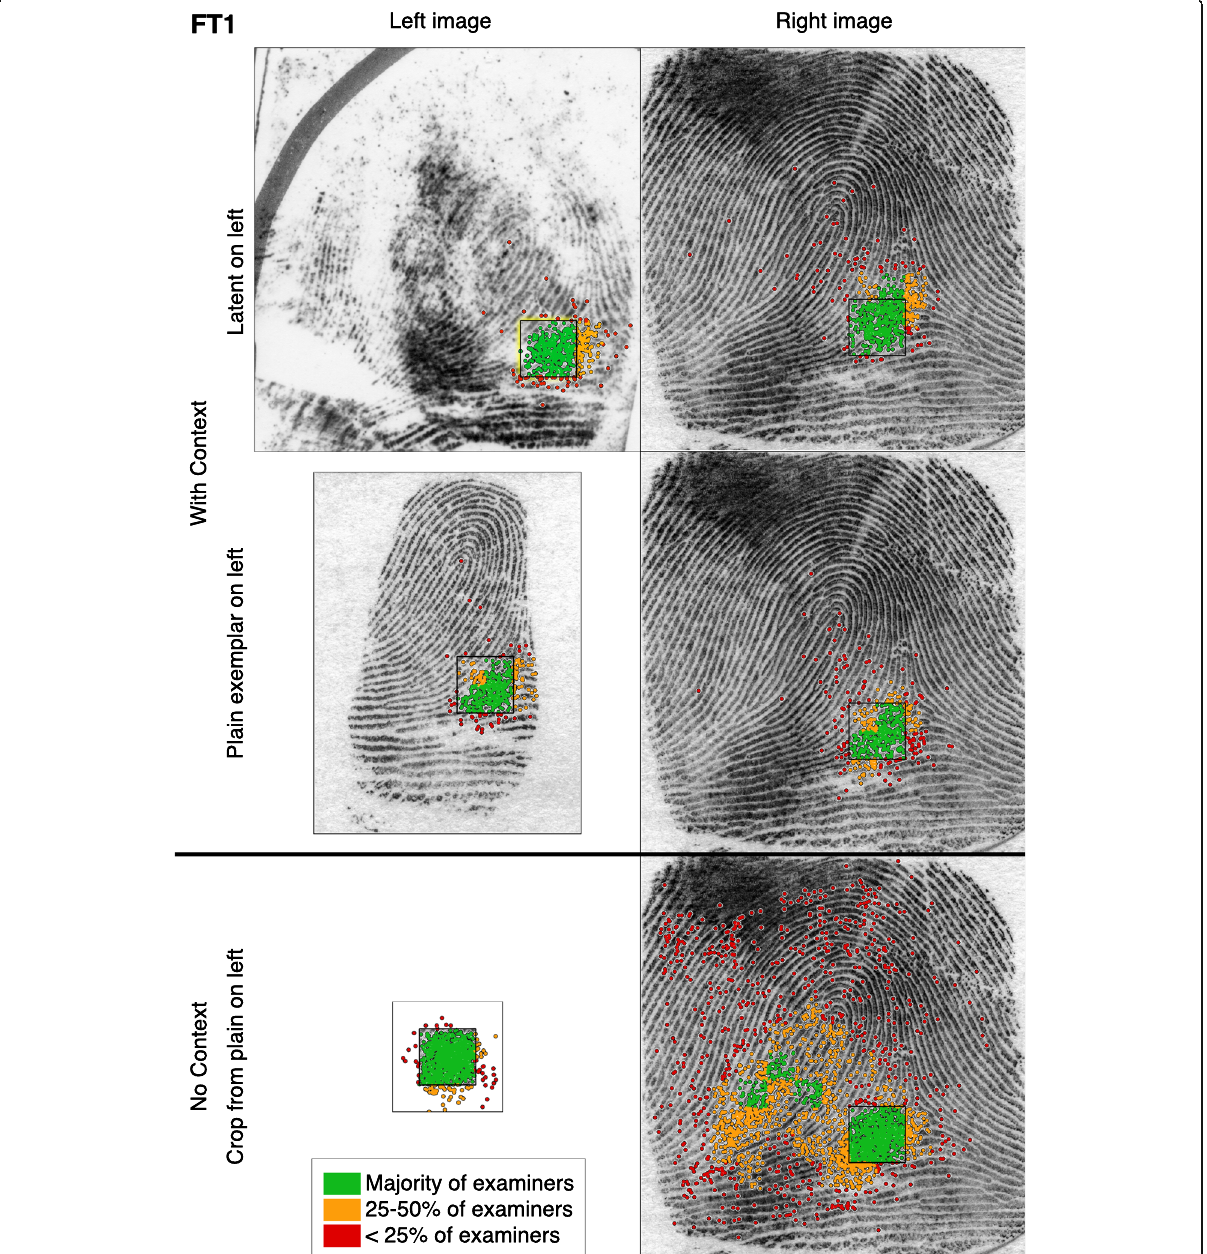
Fig. 4 Aggregate of Comparison-phase fixations from all examiners on one image set (FT1). Target area is shown here as a black outline. Color- coding describes the proportion of examiners who had any fixations in each cell. ( N = 35 examiners (FT1 Latent ), 32 (FT1 Plain ), and 37 (FT1 Cropped )). FT1 images without fixations are shown in Fig. 1. See Additional file 1: Appendix SI-6.1 for Analysis-phase fixations and other image